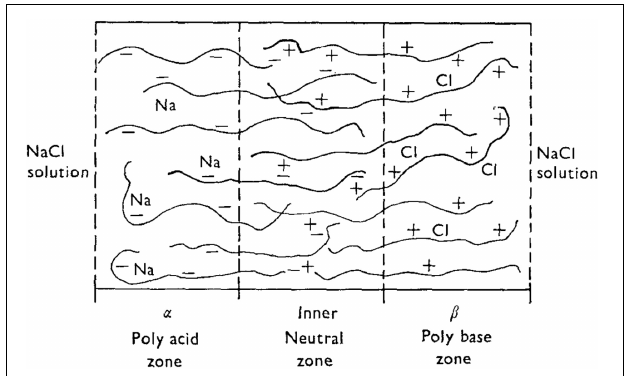
FIGURE 8 | Schematic of a bilayer structure of Shashoua (1967) with an anionic polyelectrolyte (polyacid) and a cationic polyelectrolyte (polybase) and an interfacial region (inner neutral zone) where the two polyelectrolytes slightly interdiffuse. From Katchalsky and Spangler